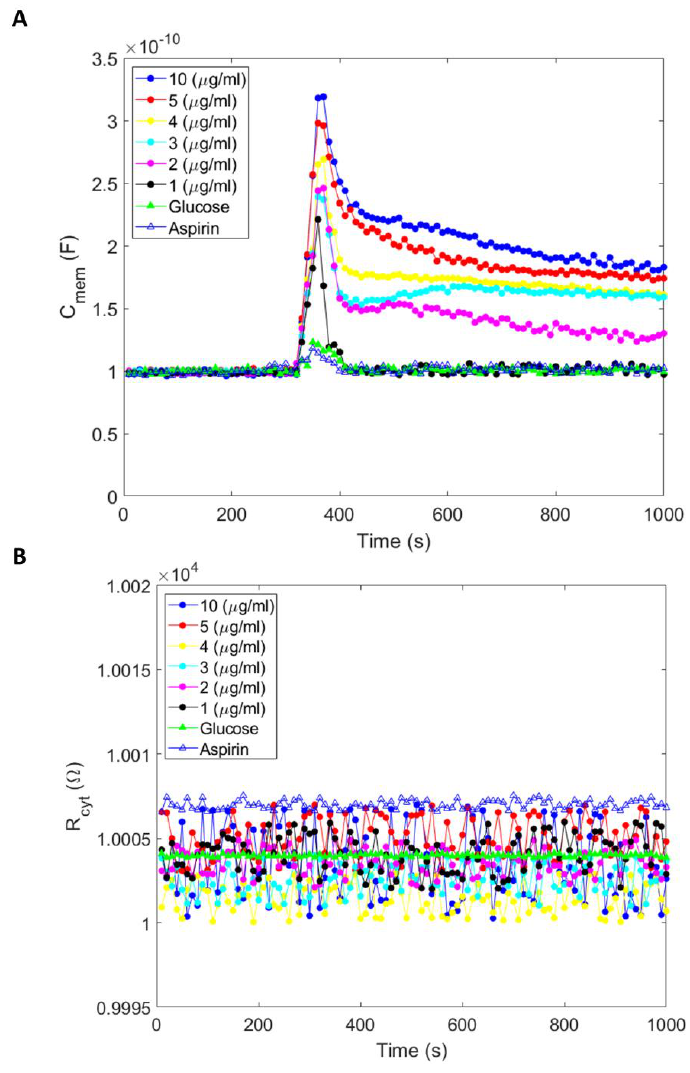
Figure 2. ( A ) Membrane capacitance and ( B ) cytoplasm resistance measurements were collected with PC-3 cells in response to amiodarone, aspirin, and glucose as a function of time. Measurements were collected every 10 s under glucose (10 µg/mL), aspirin (10 µg/mL), and various concentrations of amiodarone (1, 2, 3, 4, 5, and 10 µg/mL).